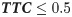
Observed flow-density (i.e., network MFD) and conflict-density relationships obtained from micro-simulation for: (a) TTC≤0.5 and TTC≤1.0; and, (b) TTC≤1.5.